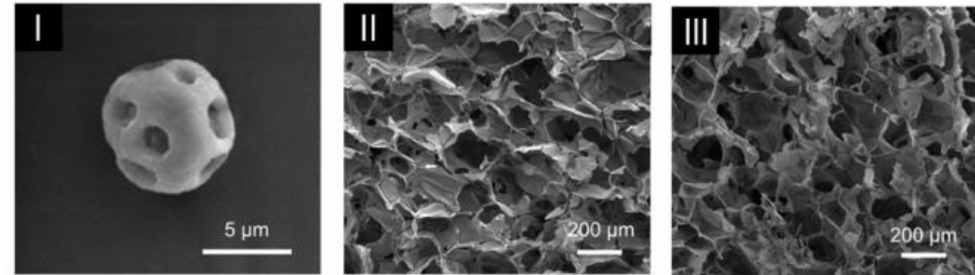
Figure 8. SEM images of ( I ) microparticle; ( II ) hydrogel; and ( III ) microparticles in hydrogel. (Adapted with permission from [42]. Copyright (2021)